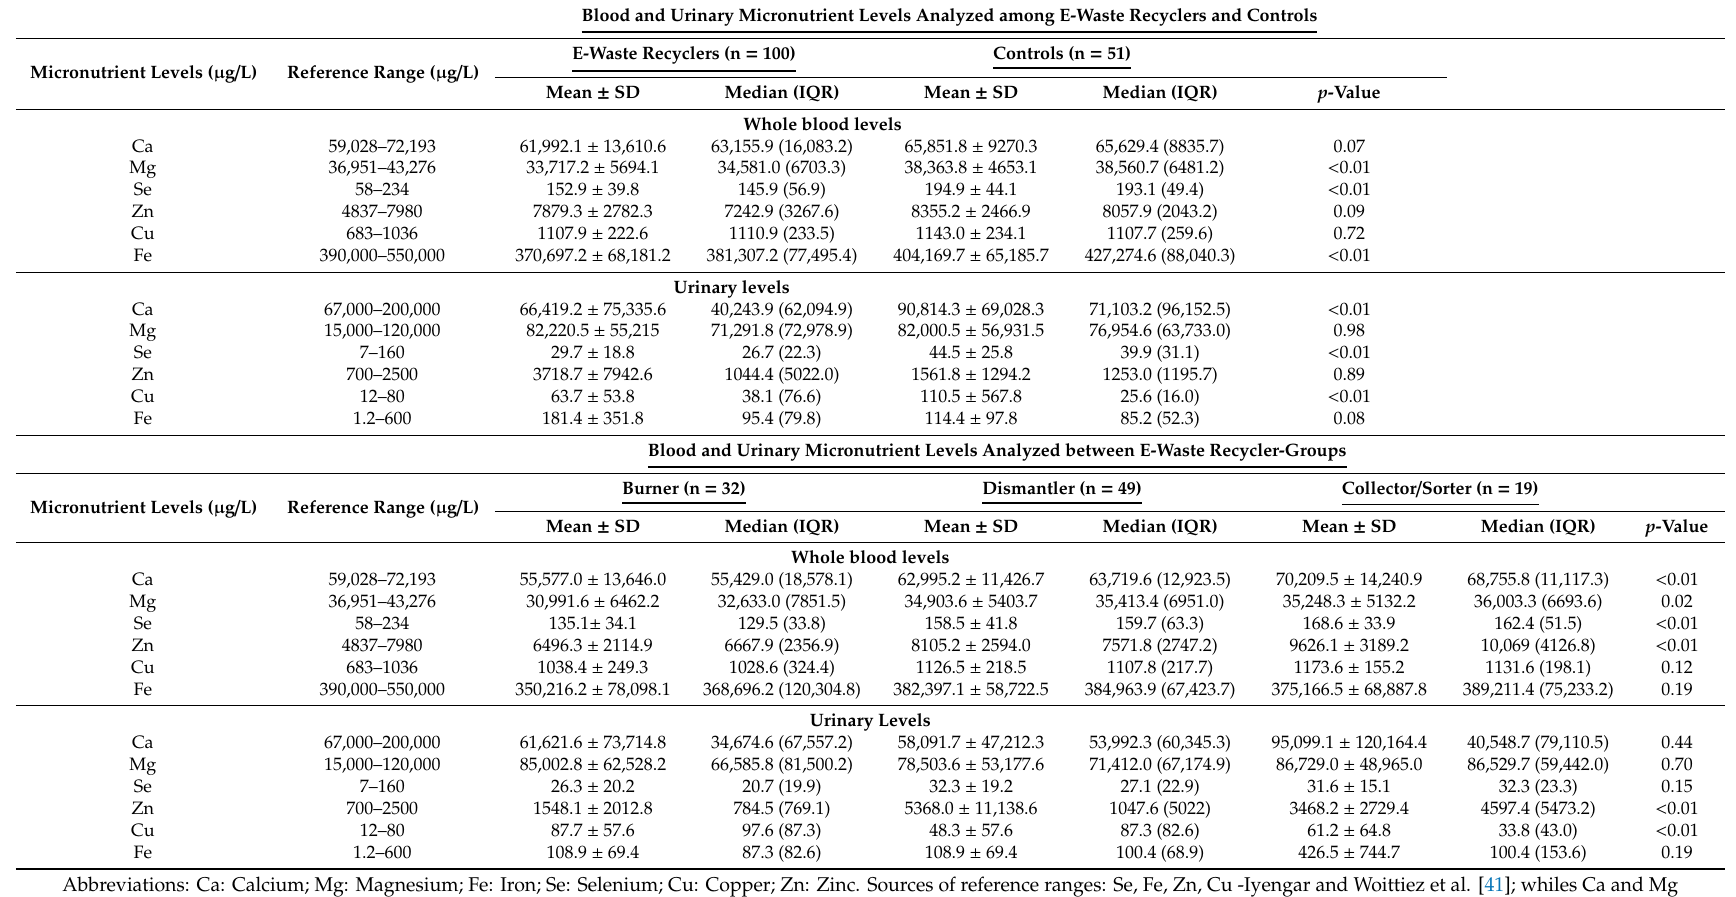
Table 3. Micronutrient levels in blood and urine of participants. Blood and Urinary Micronutrient Levels Analyzed among E-Waste Recyclers and